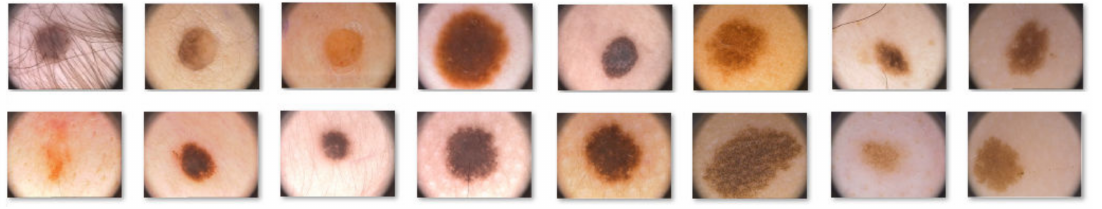
Figure 1. Common nevus images extracted from PH 2 and ISIC 2019 databases.